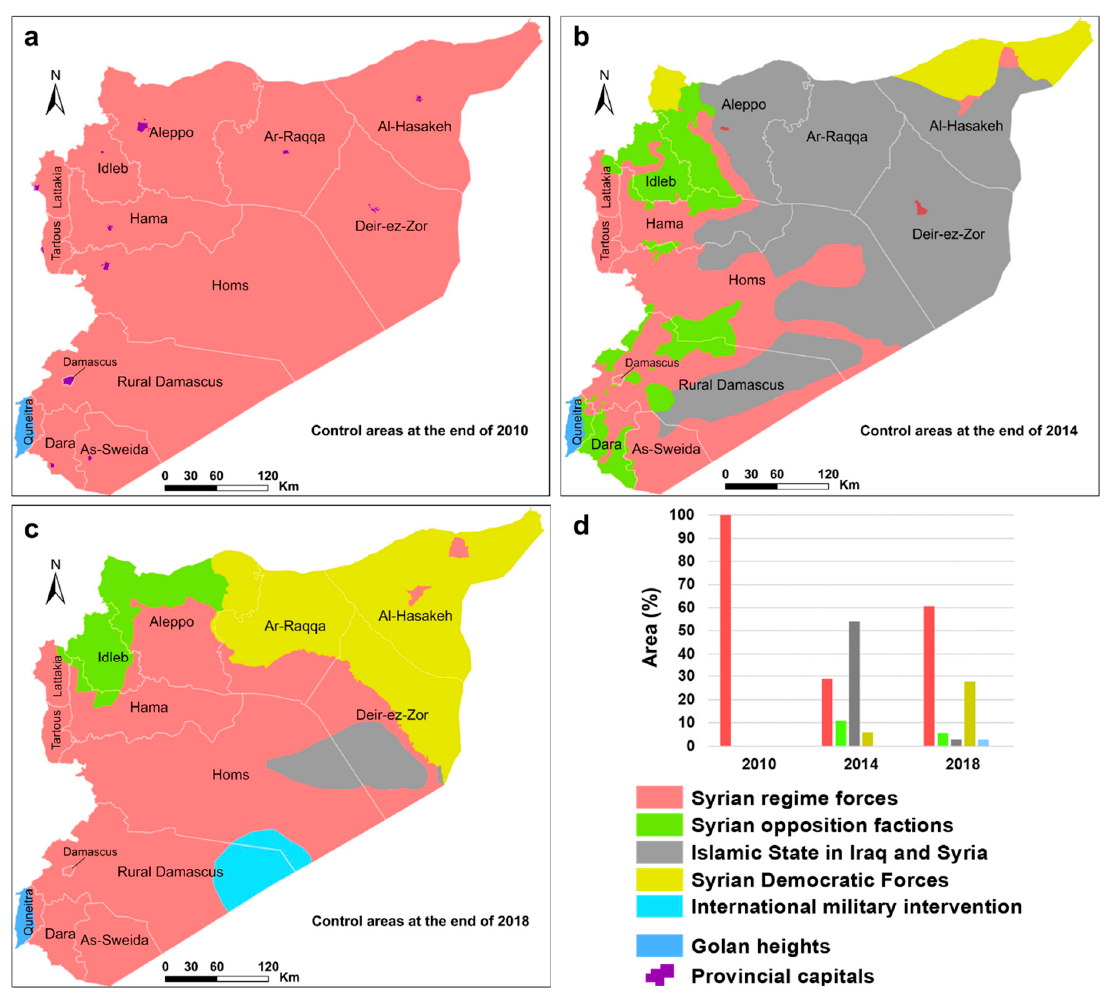
Figure 2. Distribution of zones of influence in Syria adapted from [72,73] at the end of 2010 ( a ), 2014 ( b ) and 2018 ( c ), and the share of land control between the warring parties adapted from [72] ( d ).